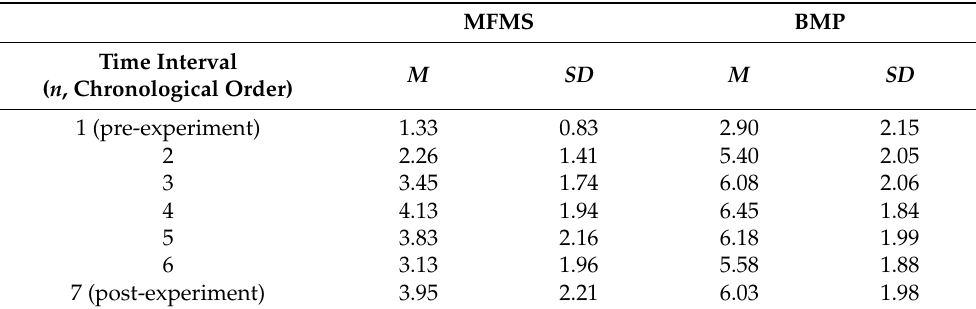
Table 1. Descriptive statistics for cybersickness and sense of presence reported across seven time intervals during the VE exposure. MFMS